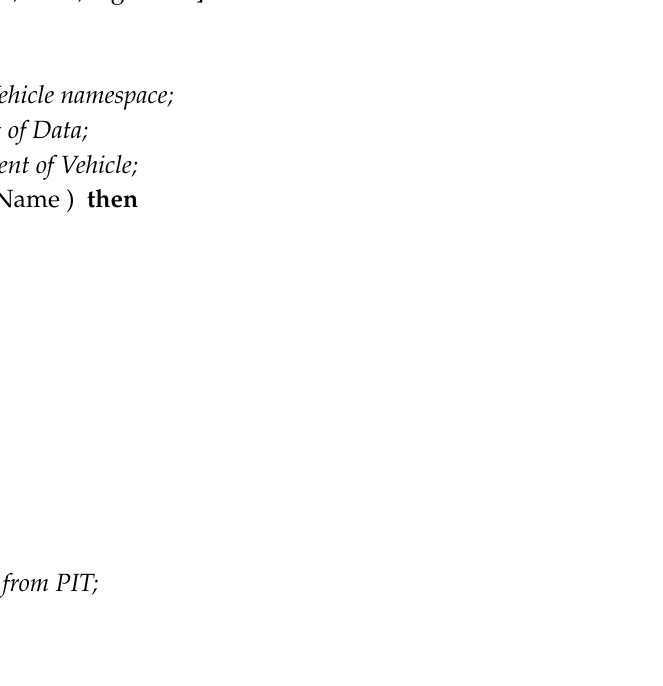
Algorithm 2 Received data packet in the Proposed Push-based Scheme for VNDNs procedure Received [Name, MetaInfo, Data,